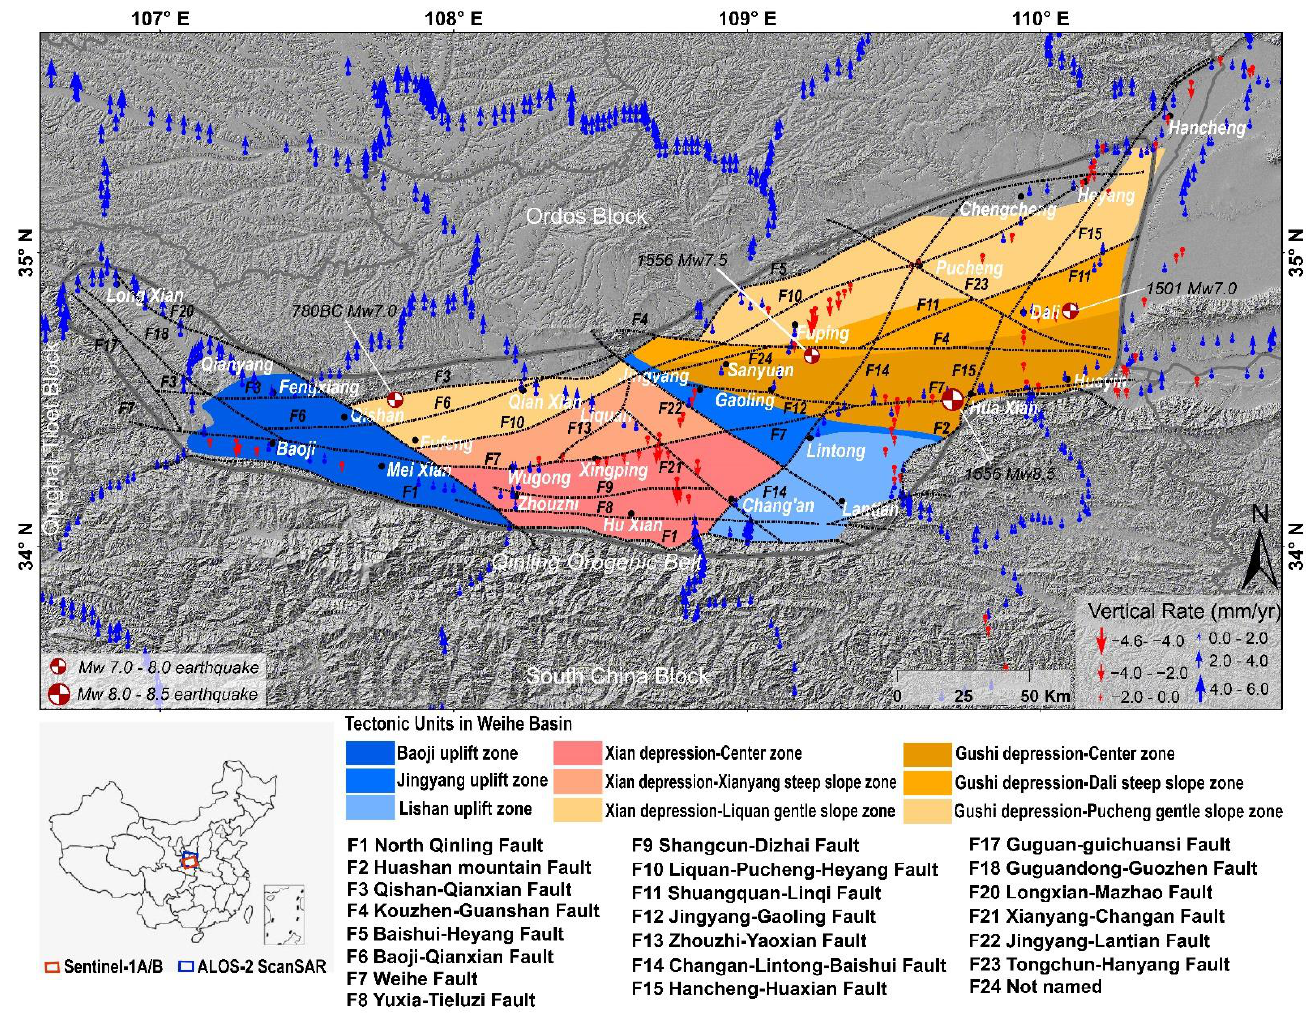
Figure 1. Geologic map of the Weihe Basin. The colored blocks show the division of the tectonic units, whose names are indicated below the figure [16,17]. The black dashed lines display the major mapped faults [4,18]. The red and blue arrows represent the locations of the leveling benchmarks. The black dots show the major cities. The red balls display historic earthquakes larger than Mw7.0. The location of the Weihe Basin in China is shown at the lower left, on which the red and blue boxes indicate the coverages of the Sentinel-1A/B and ALOS-2 images, respectively.